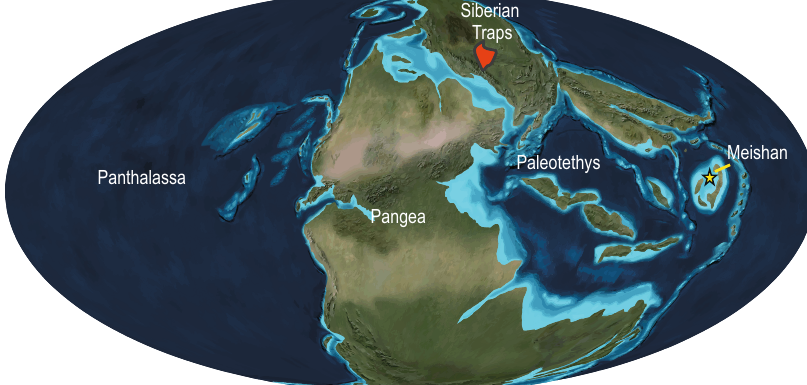
Fig. 1 | Late Permian global paleogeography. The Meishan section and Siberian Traps are indicated by yellow star and red area, respectively. source map © 2020 Colorado Plateau Geosystems